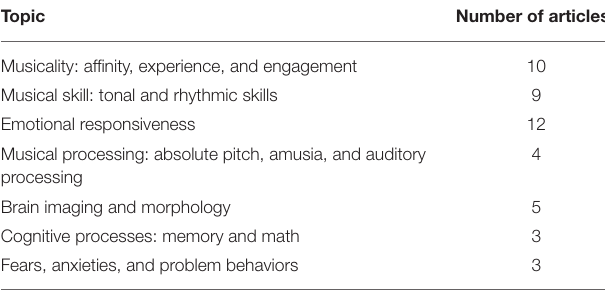
TABLE 1 | Number of articles included in each